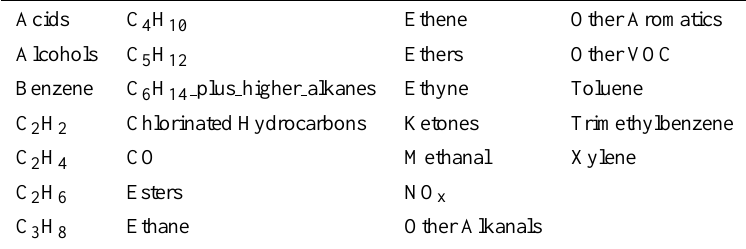
Table 1. List of chemical species available in the anthropogenic inventory developed by the RETRO program.